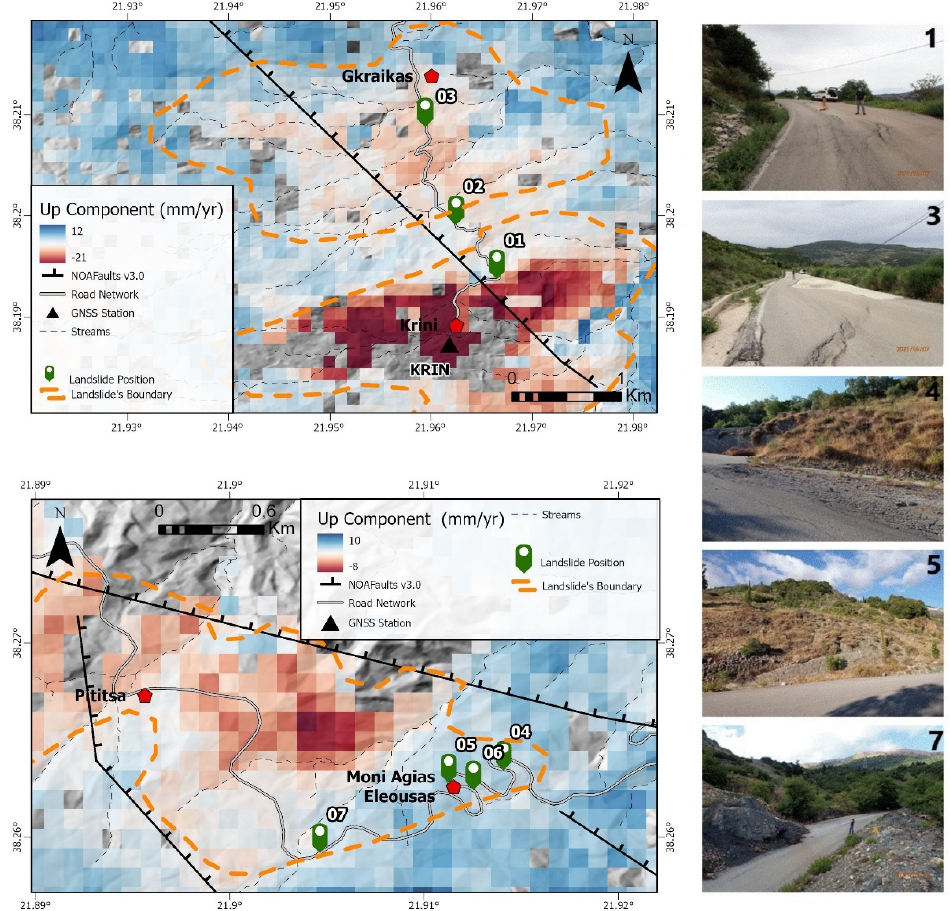
Figure 12. Maps showing U-D component of displacement rate (left panel, 2016–2021). Upper panel map includes the landslide of Krini and Graikas, and the bottom panel map includes the landslides of Pititsa and Agia Eleoussa, respectively. On the right side we provide field photos with numbers corresponding to the green markers on the maps.